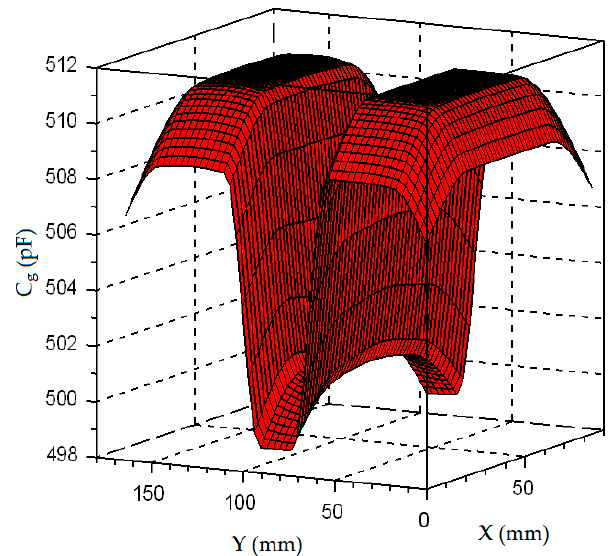
Figure 6. The 3D plot of the coupling capacitance C g as a function of the relative position.